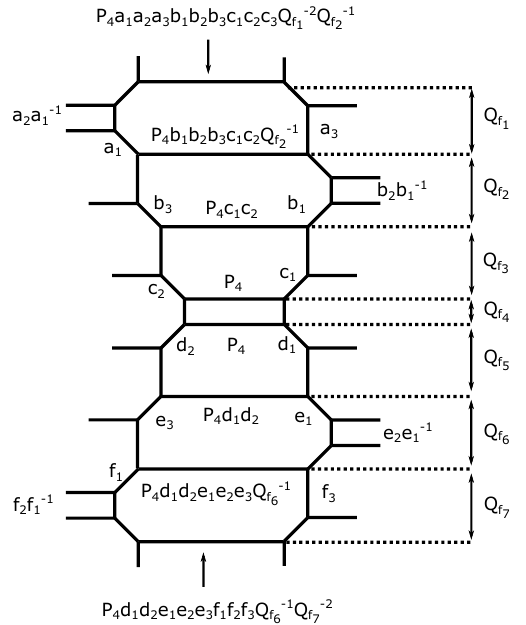
Figure 48. Local geometry for the middle SU(8) gauge node in the affine e 7 Dynkin